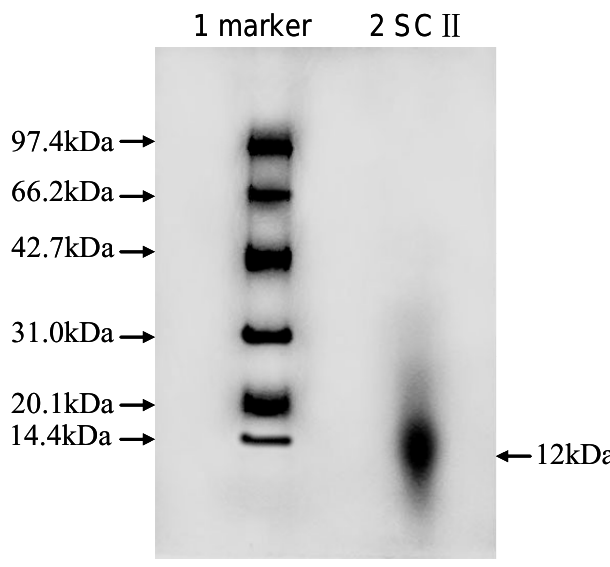
Figure 1. SDS-polyacrylamide gel electrophosesis pattern of collagen from shark cartilage. Electrophoresis was performed on 7.5% polyacrylamide gel and the peptides were stained with Coomassie Brilliant Blue. A 12 kDa peptide, corresponding to the predicated size of molecular weight protein marker, was present in the sample band. Line 1: molecular weight protein marker; Line 2: type II collagen from shark